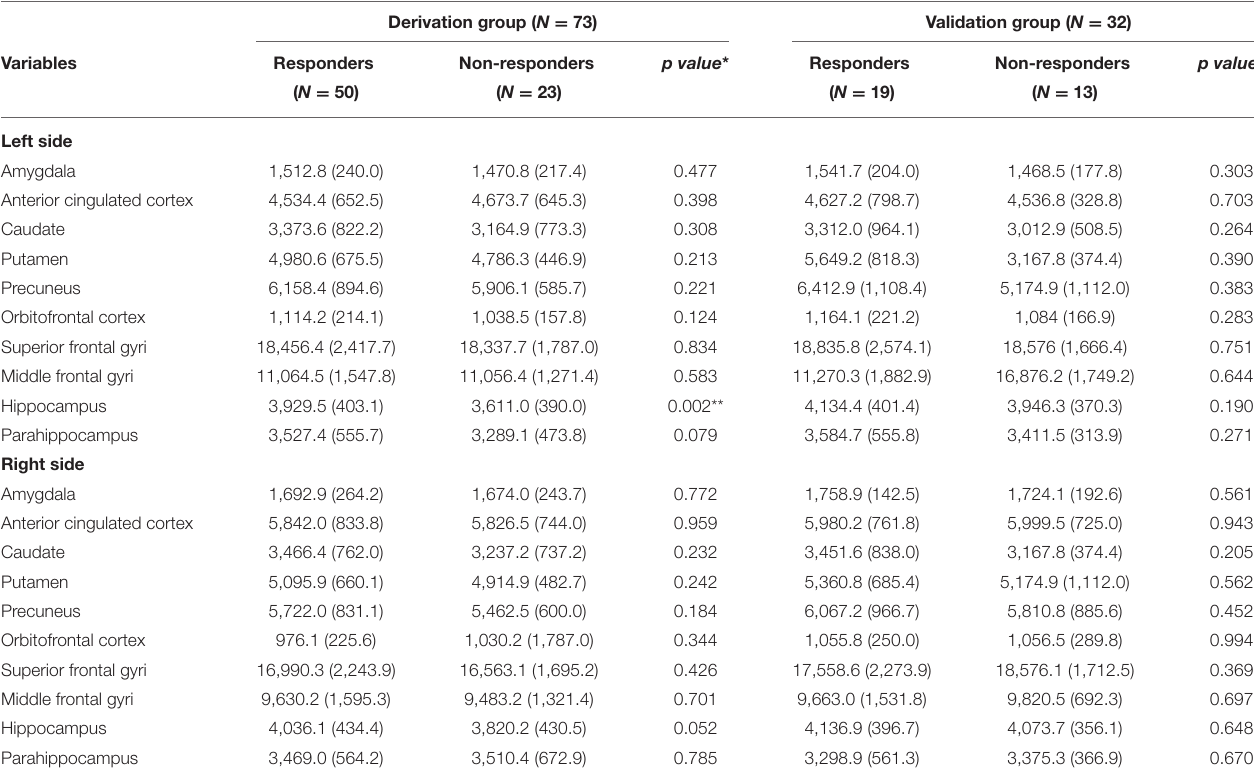
TABLE 3 | GMV of ROIs (mm 3 ) of responders and non-responders in the derivation